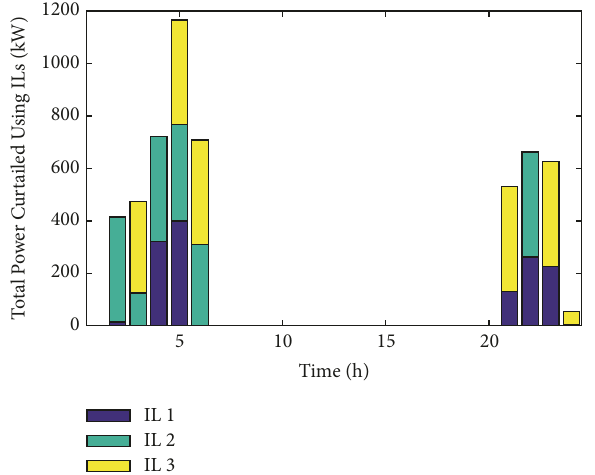
Figure 13: Curtailment of ILs in modified IEEE 57-bus system.